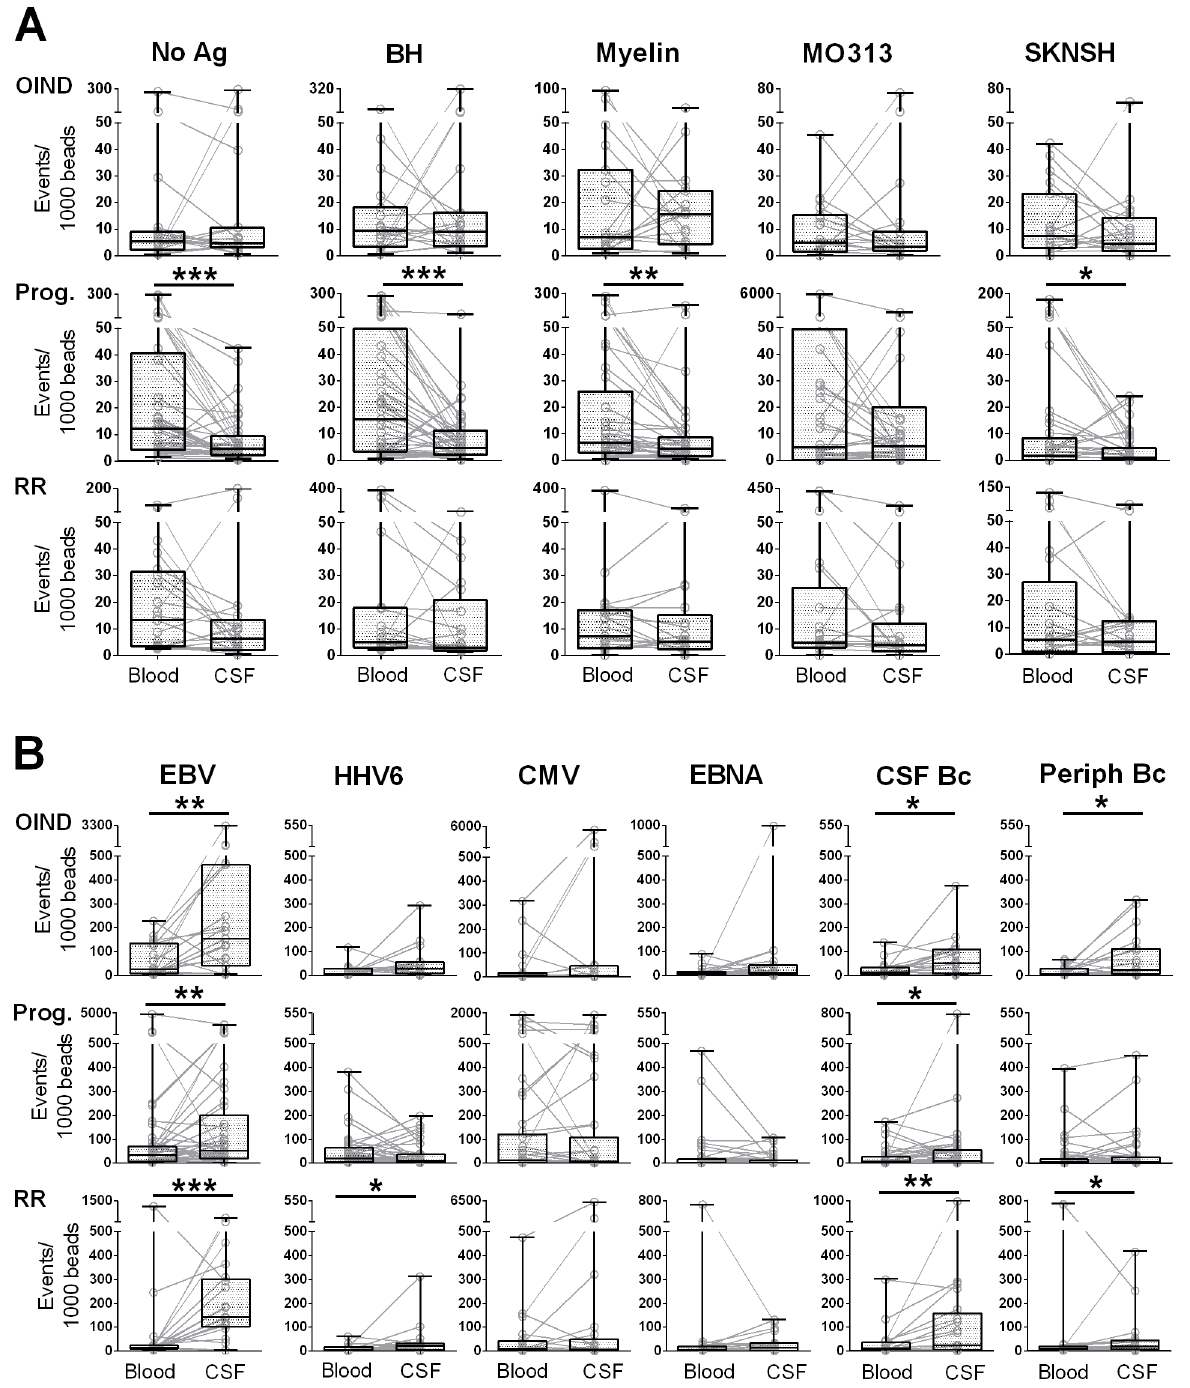
Figure 3. Enrichment of intrathecal T cell reactivities to foreign Ag’s. Intracellular cytokine secretion of each research subject was analyzed for IFN- c + , TNF- a + and double positive CD4 + T cell events. The sums of all cytokine positive events were normalized to beads. Paired T cell reactivities to unloaded DCs (No Ag) and auto-Ag’s ( A ) and foreign Ag’s ( B ) are shown for the peripheral (Blood) and intrathecal (CSF) compartment for each subject. Overlaid box plots represent median values with 25 th and 75 th percentiles; black lines indicate minimum and maximum values; *0.01 , p , 0.05, **0.001 , p , 0.01, ***p , 0.001 .